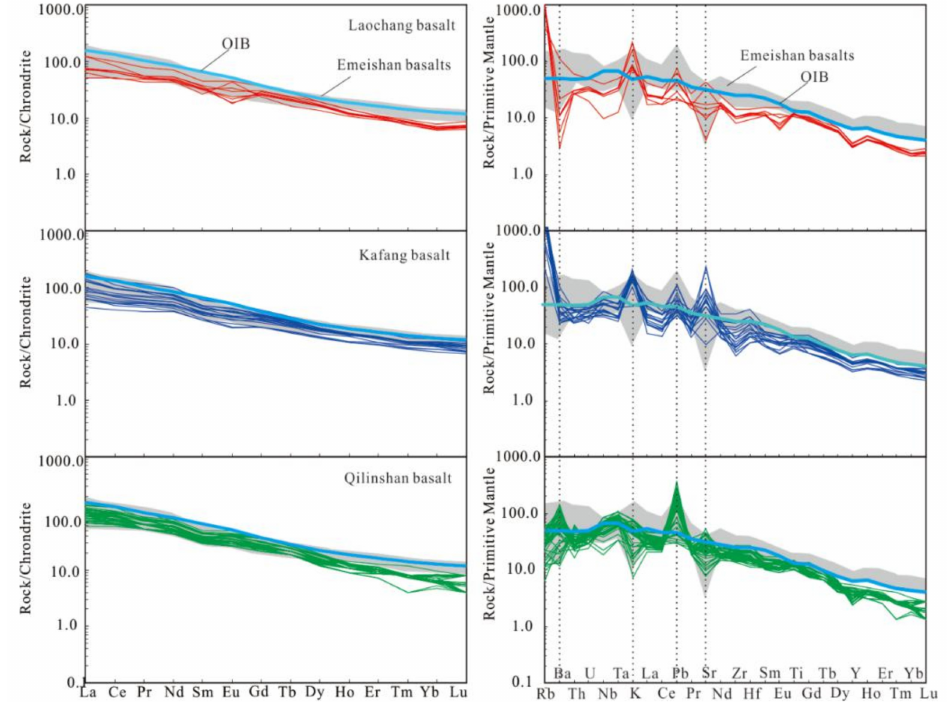
Figure 5. Chondrite normalized REE patterns and primitive mantle normalized trace element patterns of the GAAB. Normalization and OIB values followed [35]. The data of Emeishan basalts from [3]. The data of Kafang from